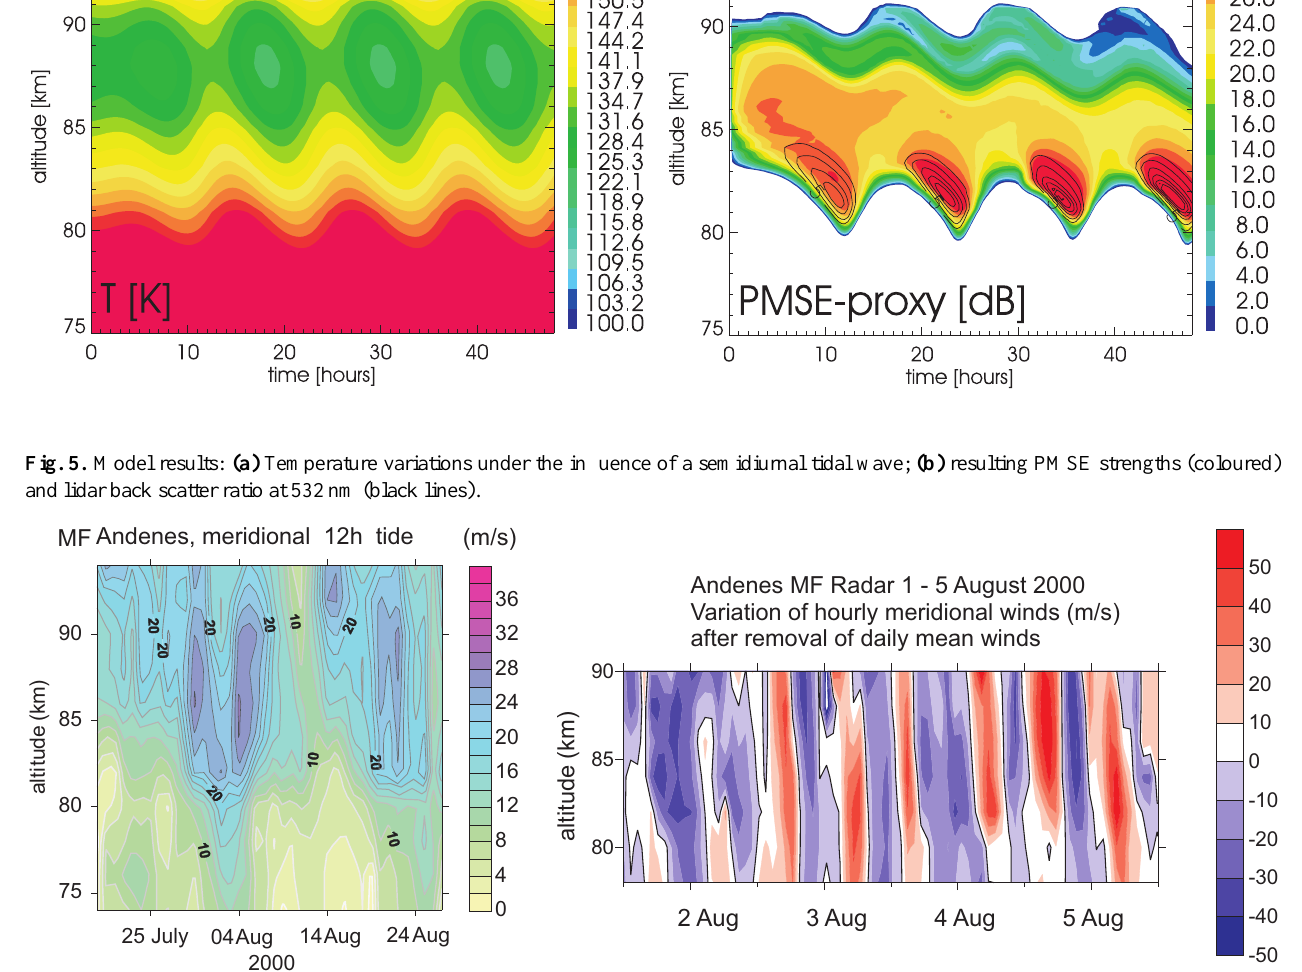
Fig. 6. Observational results: (left) Amplitude of the semidiurnal tide derived from the Andenes MF radar, (right) Variation of hourly meridional winds. Daily mean background winds are